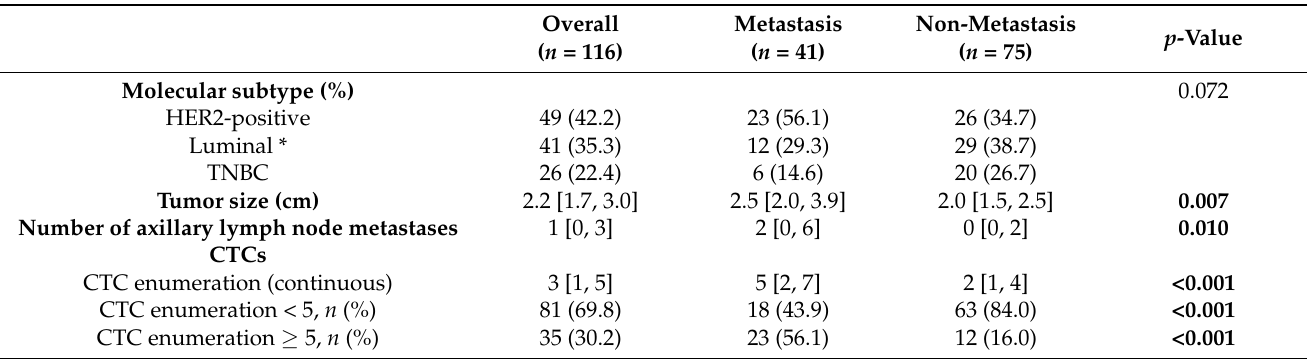
Table 2. Patient’s